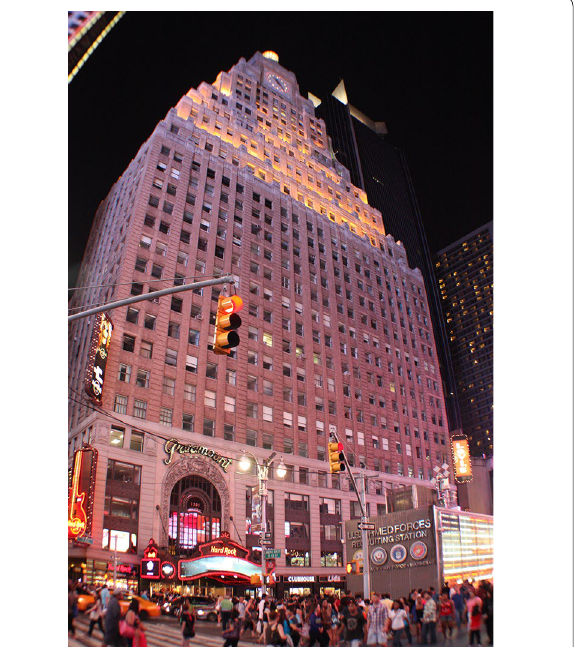
Fig. 5 The Paramount Building in New York or the film